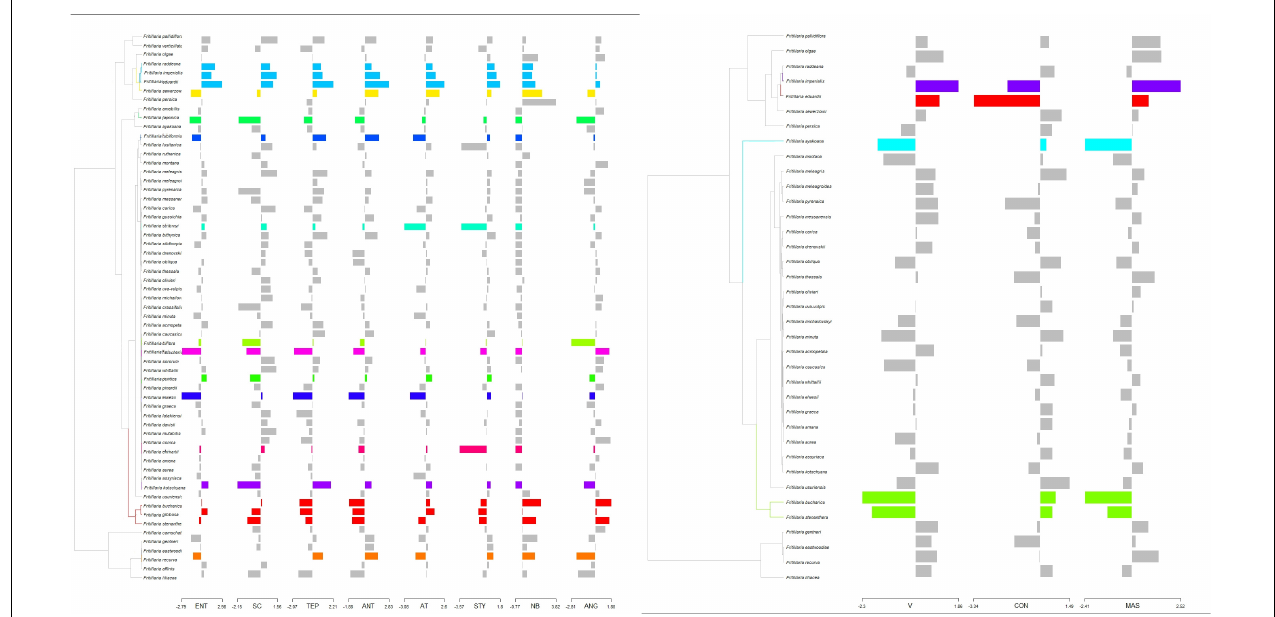
FIGURE 6 | Estimated shifts in phenotypic optima of flower traits assessed for studied Fritillaria traits. Shifts in adaptive peaks are indicated with asterisks and convergent shifts in adaptive peaks have the same branch colour. Left: shift configuration. Right: bar graphs showing the traits combined for analysis. (A) Shifts calculated on the base of flower traits (with the exception of anthers-stigmas distance where too many 0 values hampered the analysis) and (B) reward properties. Difference in number of species in (A,B) results from missing data in the case of reward properties.